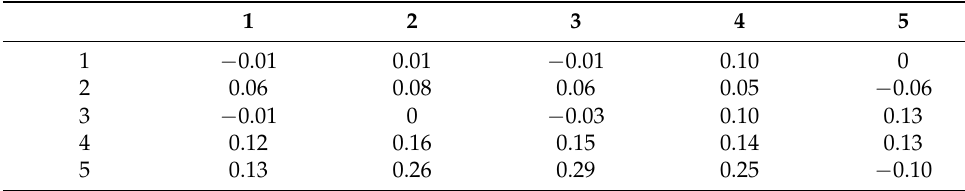
Table 4. Computed % errors between u 2